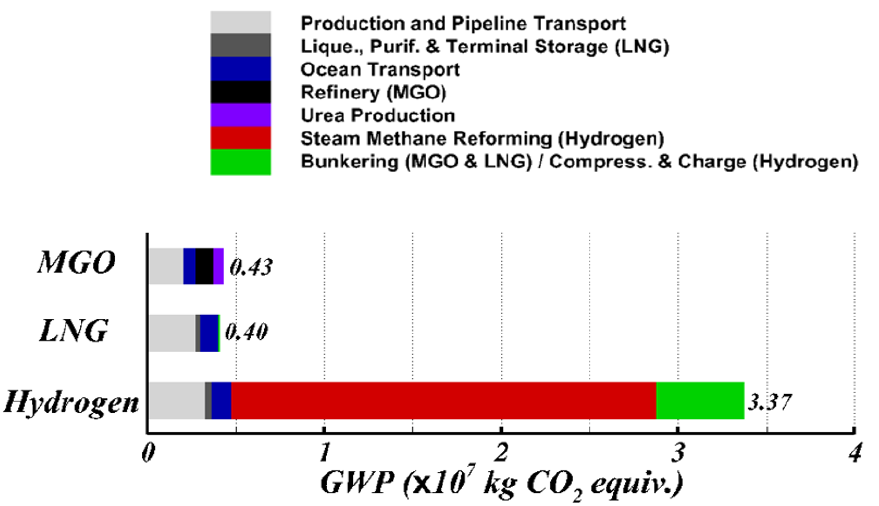
Figure 13. GWP results in the well-to-tank phase.